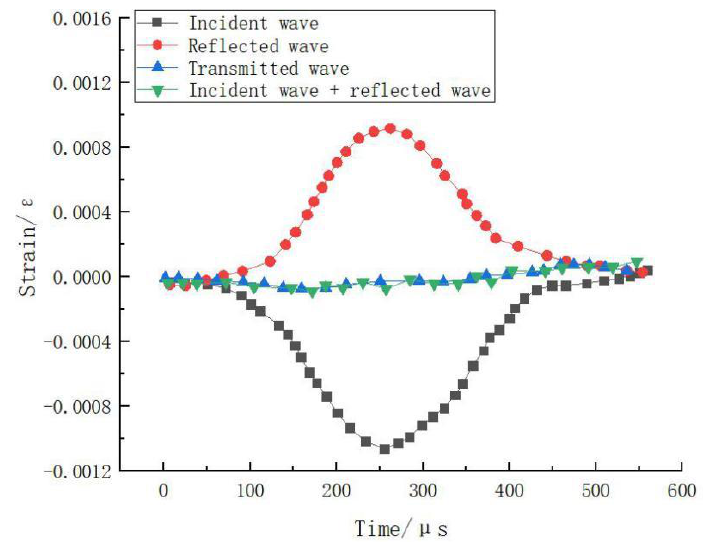
Figure 12. Dynamic stress balance verification.